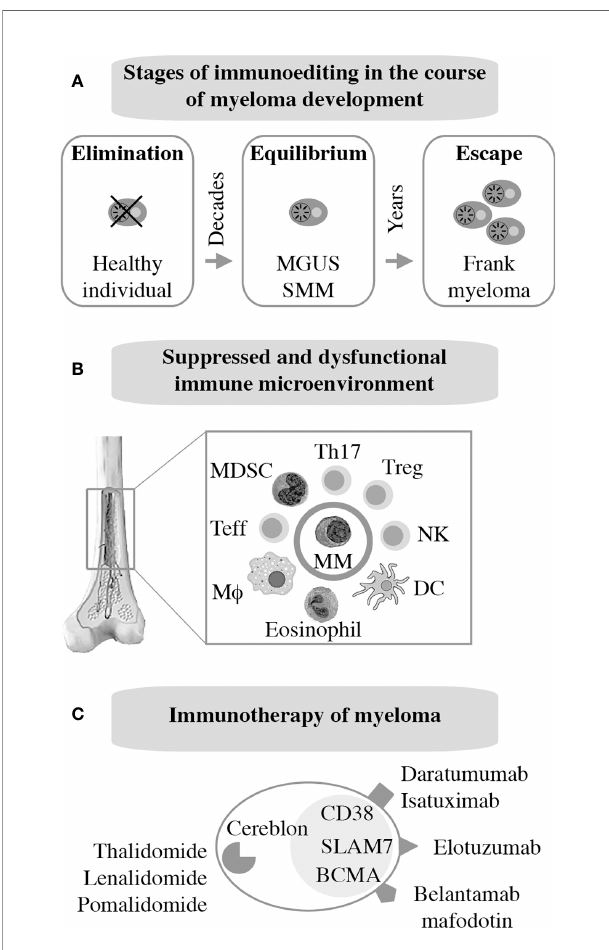
FIGURE 2 | Immunopathology and -therapy of myeloma. Evidence indicates that myeloma development is promoted, in part, by the gradual breakdown of immunosurveillance (A) . Consequently, patients with myeloma have a suppressed and dysfunctional immune microenvironment (B) . 2 subsets of Tregs that discriminate MGUS from MM (31); 2 subsets of terminal effector T cells (T TE ) are involved in MGUS to MM transition (32); Attrition of BM-resident T cells due to loss of “ stem-like ” TCF1/7hi T cells may underlie loss of immune surveillance in myeloma (33). Enhanced understanding of this microenvironment has been key for the development of immunotherapies of myeloma